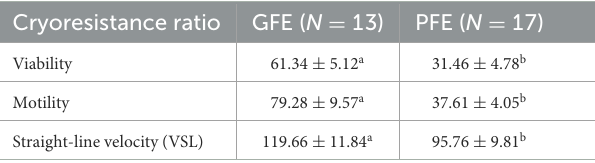
TABLE 1 Semen quality of ram freshly ejaculated spermatozoa ( n = 30). TABLE 2 Cryoresistance ratios (mean ± SEM) for ram